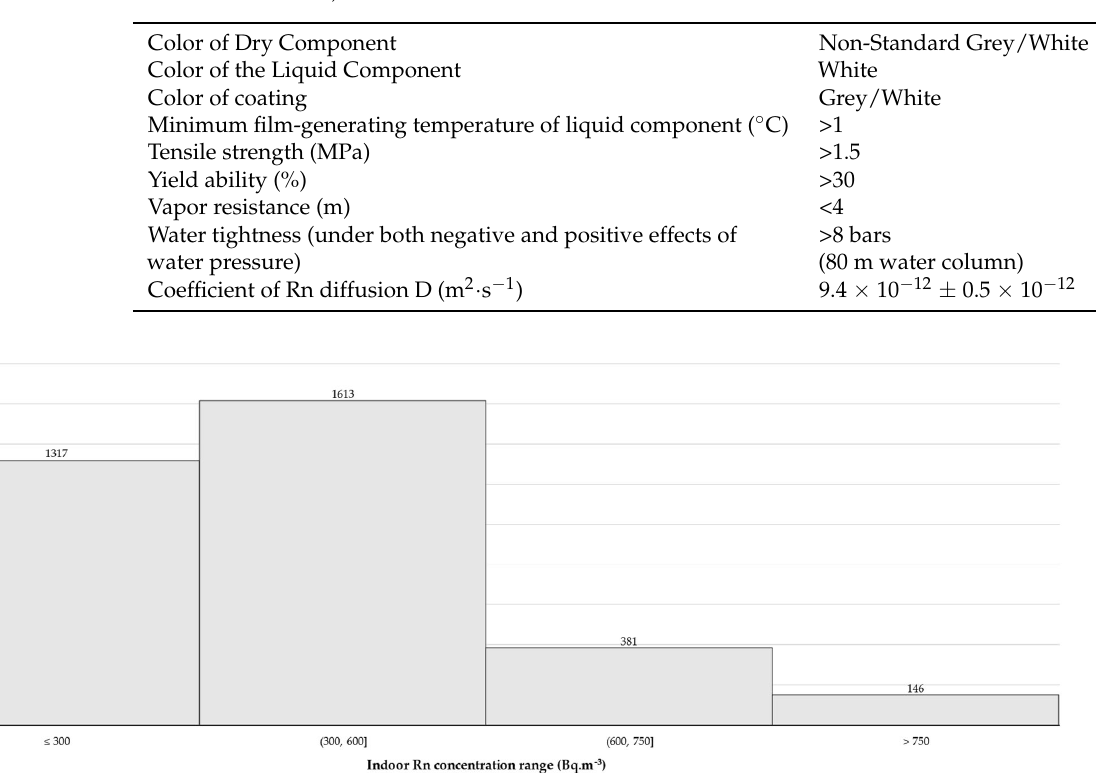
Table 4. Physical and mechanical parameters of WATERFIN PV (http://www.betosan.cz, accessed on 6 December 2022).